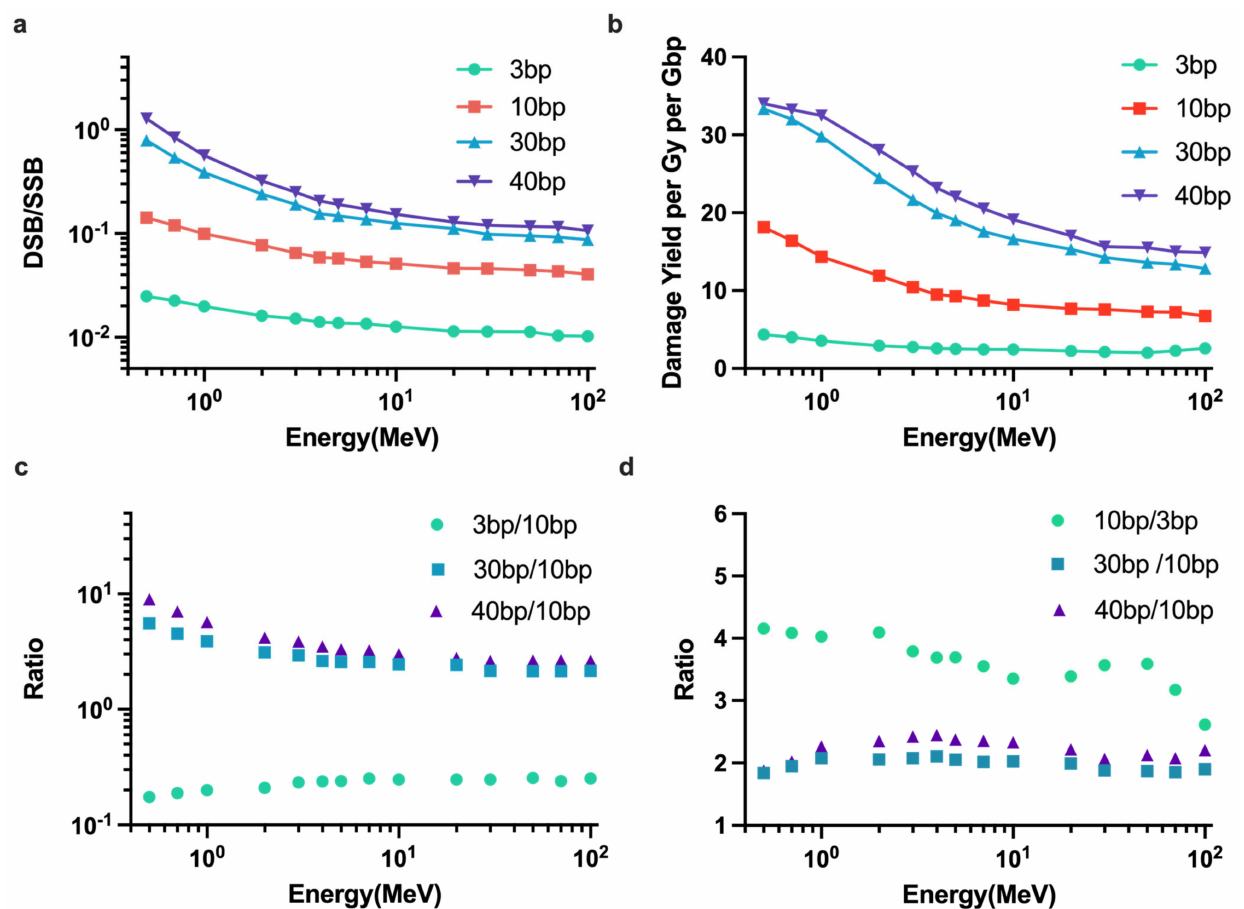
Figure 7. DNA damage simulations with varying damage clustering distance. ( a ) The ratio of the yield of DSBs to the yield of SSBs. ( b ) The yield of DSBs as a function of incident proton energy with damage clustering distance of 3 bp, 10 bp, 30 bp and 40 bp. ( c ) The ratio for DSB/SSB of 10 bp results to other clustering distance used in this work. ( d ) The ratio for DSBs yield of 10 bp to other clustering